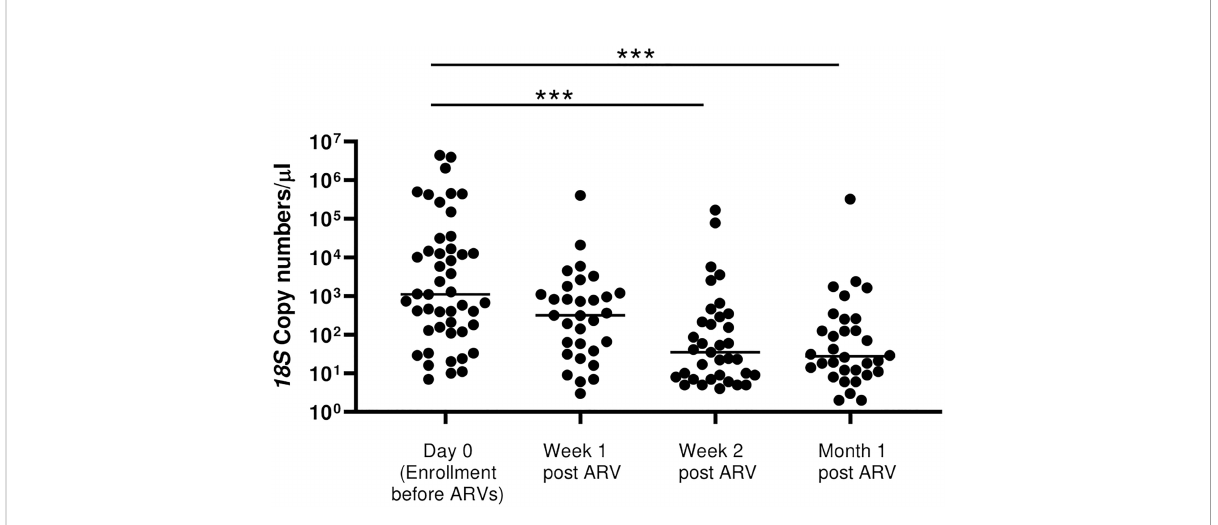
FIGURE 5 Rate of drop in 18S copy numbers among all the HIV-positive newly diagnosed following initiation of ART. There was a stepwise drop in parasitemia at Week 1, Week 2 and at month 1 following initiation of ART/TS ( p =0.0001 by Kruskal Wallis test). However, post-hoc analysis by Dunn ’ s test to compare the means showed signi fi cant differences between Day 0 with Week 2 (*** p =0.0005) and between Day 0 with Month 1 (*** p